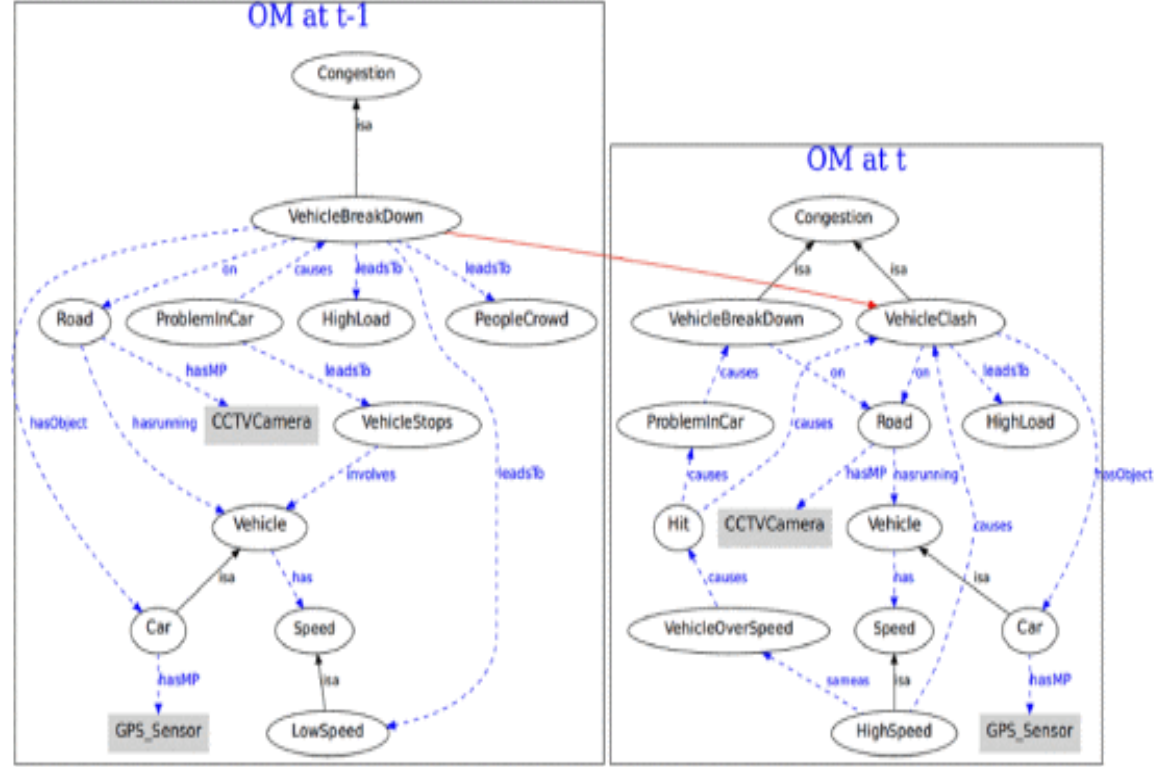
Fig.8. DBN based result for tracking situation in smart